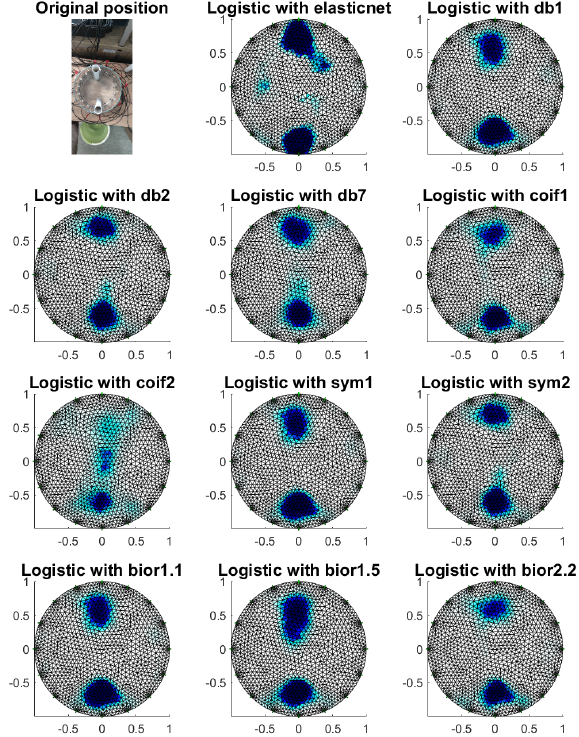
Figure 18. Image reconstruction with phantoms at electrodes 1 and 9.